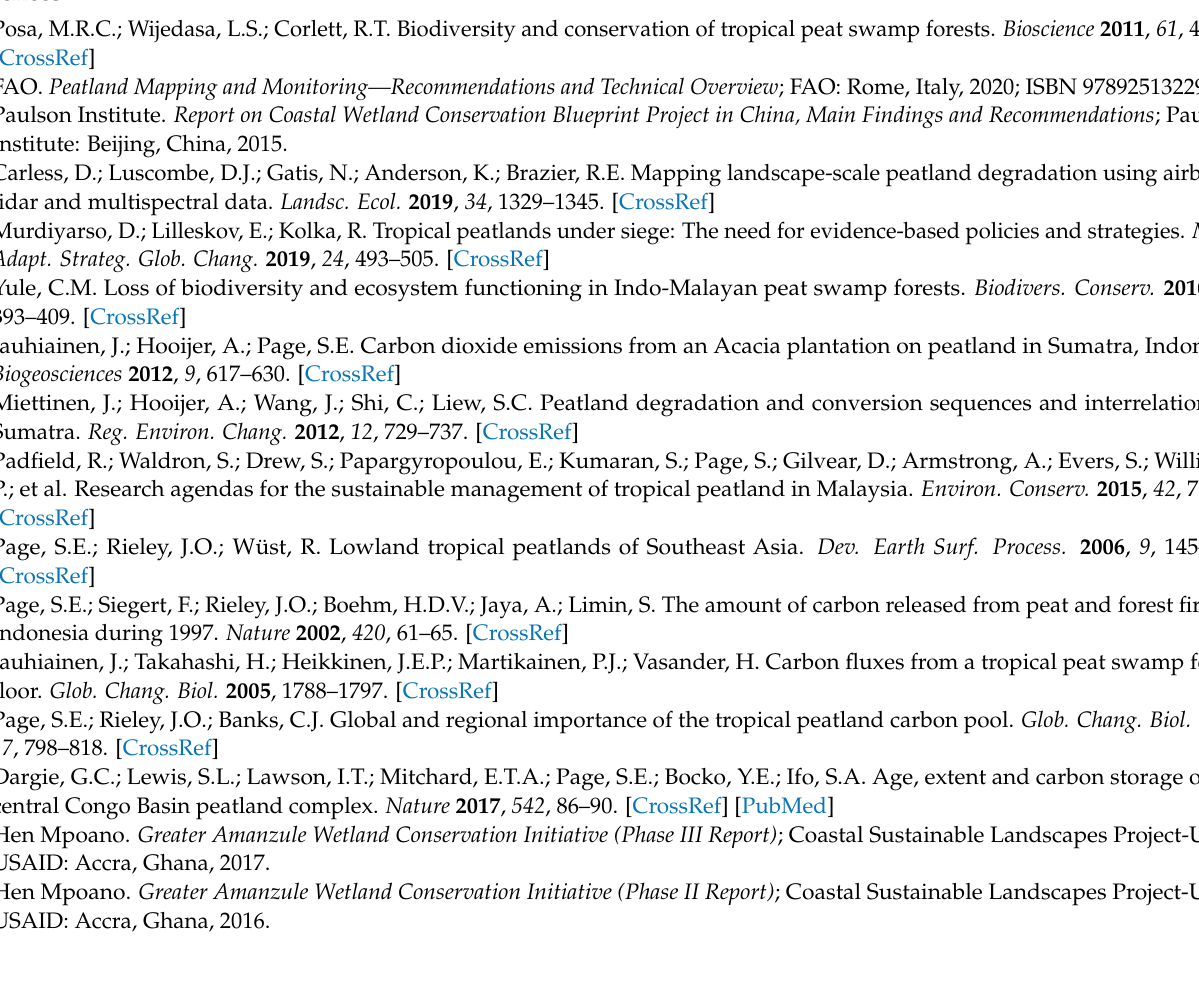
Confusion matrix for land cover classification of S2+ dataset. Table S3. Confusion matrix for land cover classification of S1 dataset. Table S4. Confusion matrix for land cover classification of S1+ dataset. Table S5. Confusion matrix for land cover classification of S2+S1+ dataset. Table S6. Confusion matrix for land cover classification of S2+S1+DEM dataset. Table S7. Feature importance for discriminating various land cover types based on the S2 dataset. Table S8. Feature importance for discriminating various land cover types based on the S2+ dataset. Table S9. Feature importance for discriminating various land cover types based on the S1 dataset. Table S10. Feature importance for discriminating various land cover types based on the S1+ dataset. Table S11. Feature importance for discriminating various land cover types based on the S2+S1+